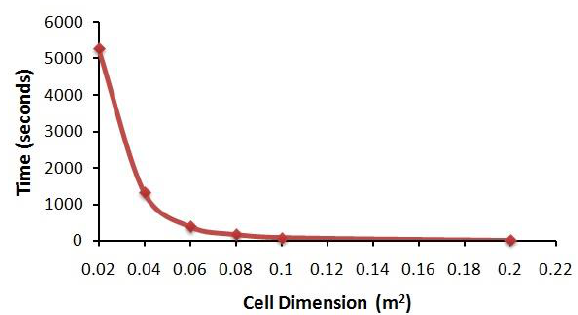
Figure 6: Plot of the time taken by the snake curve to move from its initial position to the final position in the six test cases of raster cell dimension analysis.